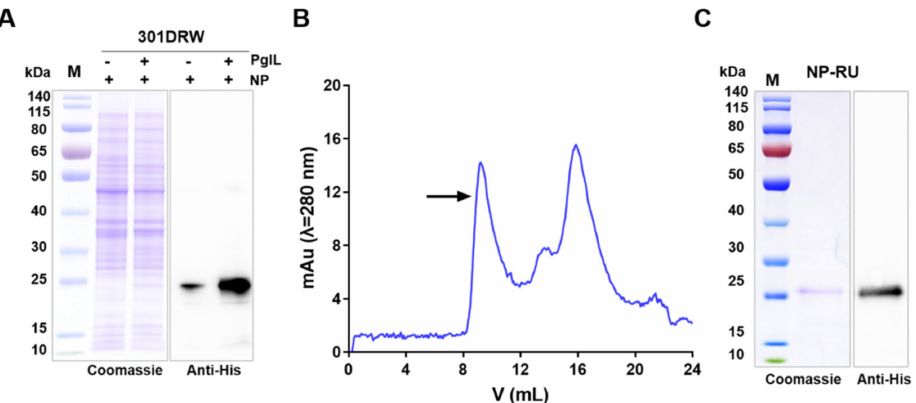
Figure 2. Expression and purification of NP–RU. ( A ) The plasmids pET28a–CTBTri and pET28a– PglL–CTBTri were transferred into strain 301DRW, respectively, and Coomassie blue staining and Western blot assays were performed to analyze the expression of CTBTri (NP) expressed alone or co–expressed with. ( B ) Analysis of purified NP–RU by size–exclusion chromatography (Superdex 200, GE Healthcare). The peak position of NP–RU is indicated by an arrow. ( C ) The purified NP–RU was detected by Coomassie blue staining and Western